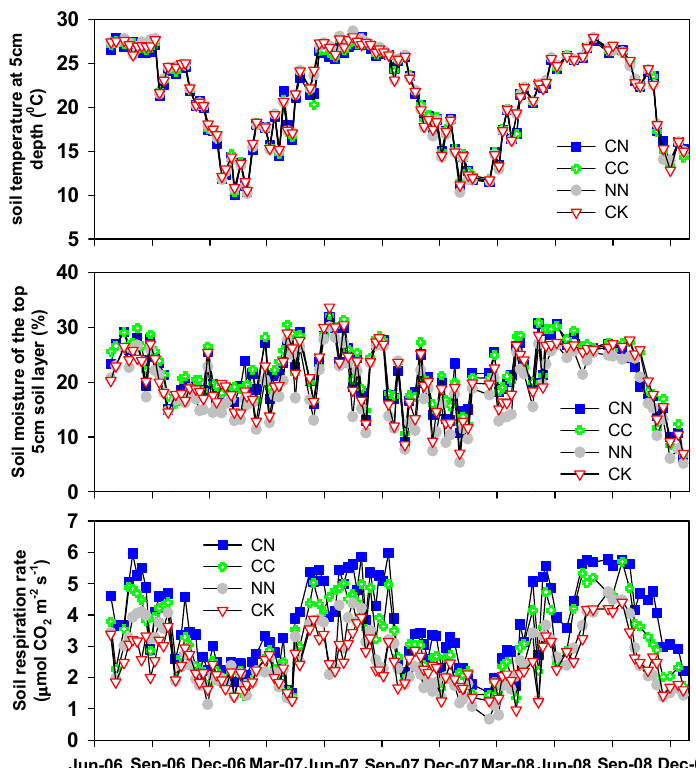
Fig. 1. Seasonal dynamics of soil temperature at 5cm below the soil surface, soil moisture of the top 5cm soil layer and soil respiration rate Fig 1. 15 under different CO 2 and N treatments. The treatments are: CK=control, NN=high N, CC=elevated CO 2 , CN=elevated CO 2 + high N.